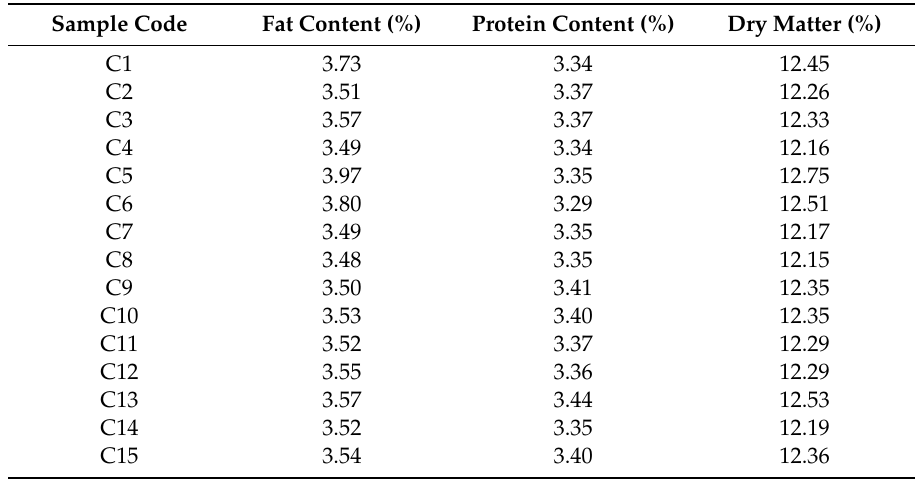
Table A1. Concentration of major whole milk constituents for all samples investigated in foam stability